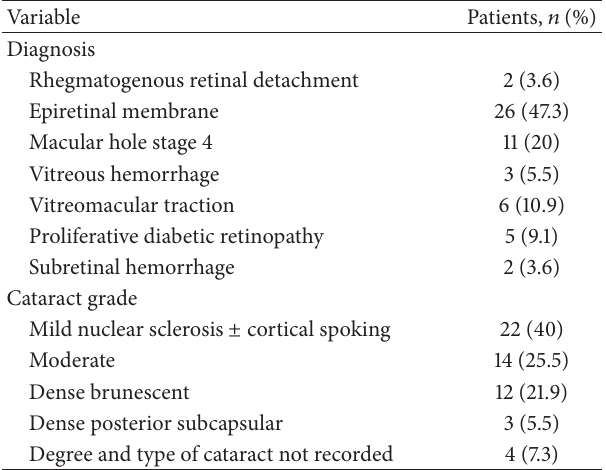
Table 2: Vitreoretinal indication and cataract